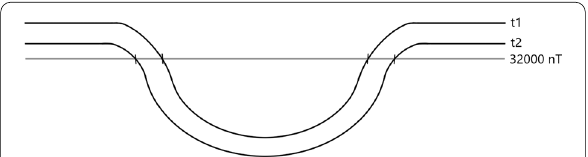
Fig. 1 Schematic illustration of a cross section of the surface field intensity under a global decrease in field intensity from time t 1 to time t 2. In this scenario, the apparent SAA area based on S 0 (1)